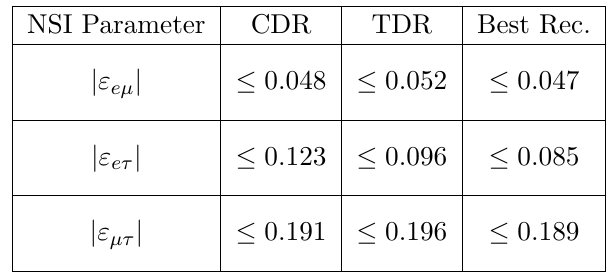
Table 2 . Same as in table 1, but for the magnitude of the non-diagonal NSI parameters which are taken to be complex here (cf. figure